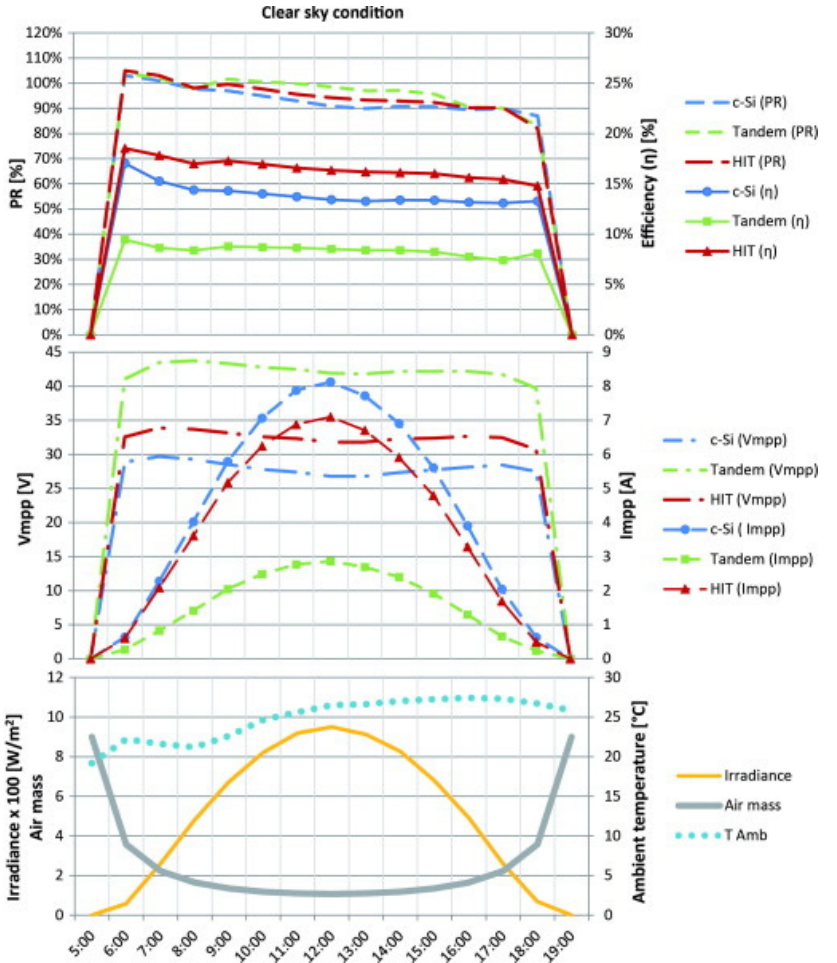
Figure 8. Hourly parameter variation and climatic data from a clear summer day [69]. Table 4. Summary of the literature studied, and the effect of different PV technologies.